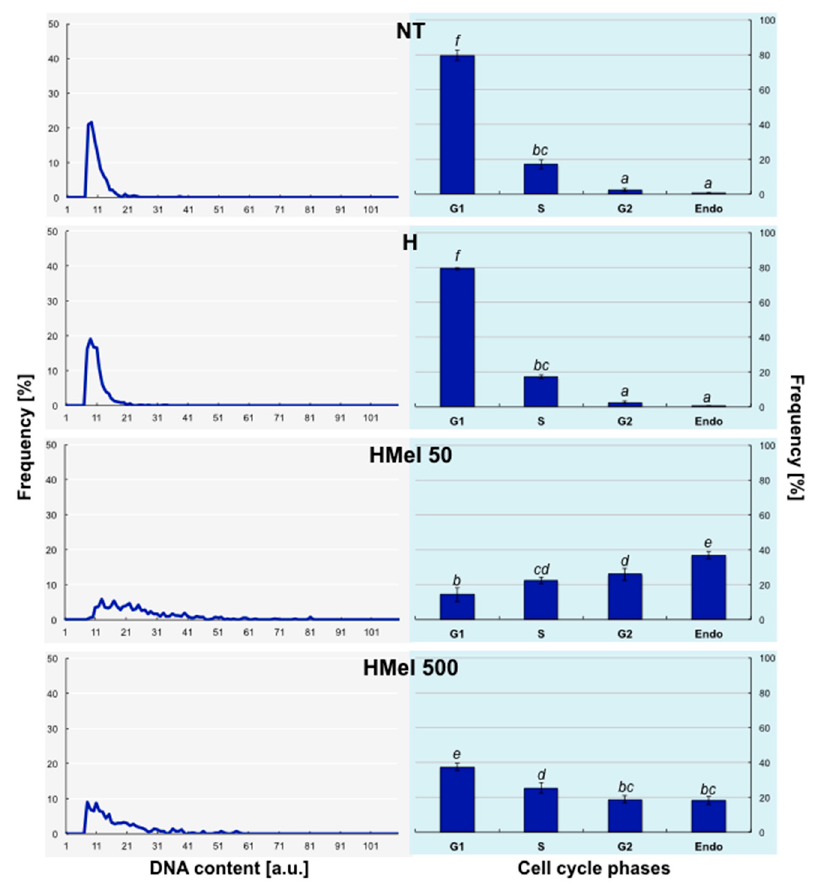
Figure 10. Effect of different maize seed hydropriming treatments on DNA content (line charts) and relative number of cells in G1, G2, S and > 4C phases/Endo (bar graphs) in the axes isolated from non-treated seeds (NT), and those from hydroprimed with water (H) and with melatonin water solutions in concentrations: 50 μ M (HMel 50) and 500 μ M (HMel 500). The seeds were imbibed/germinated in water at 5 °C in darkness for 14 days (S [ ■ ]—chilling stress). The results of cell cycle phase distribution are expressed as means of 5 analyses ±SEM. Two-way ANOVA and Duncan’s post-hoc tests were performed. The small lowercase next to the values show statistical significance at the specified p . Cell cycle phases distribution—ANOVA results: Seed Variant (NT,H,HMel 50,HMel 500) F (3;64) = 0, p = 1; Cell Phase (G1,S,G2,Endo) F (3;64) = 291.08, p < 0.0000001; interaction Seed Variant × Cell Phase F (9;64) = 102.89, p < 0.0000001.